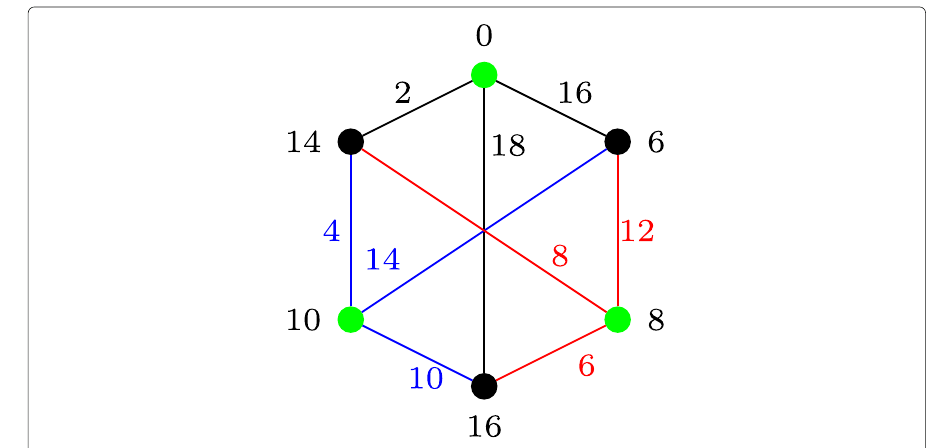
Fig. 1 An edge even graceful labeling of the graph K